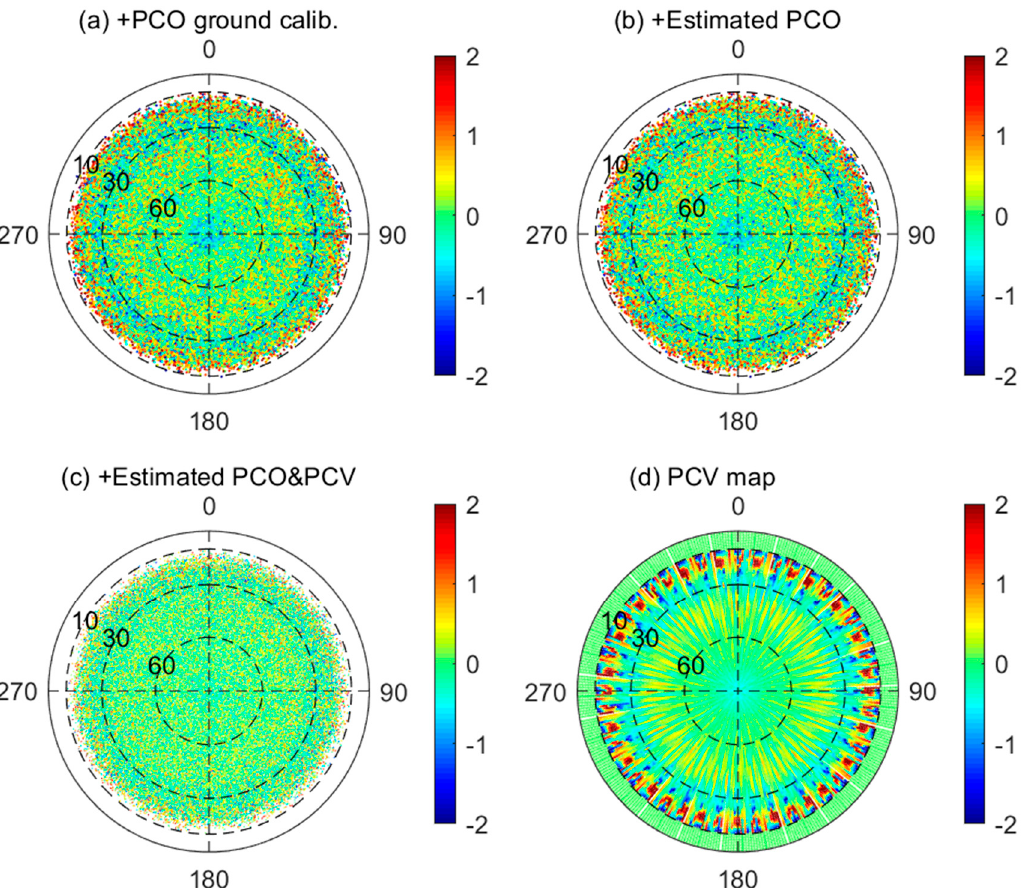
Figure 8. Ionosphere-free carrier phase residuals (cm) for DOY 201 to 231, 2018 and azimuth-elevation diagram of the 5° × 2° phase center variation (PCV) map (cm) for the CSES positioning antenna. Figure ( a ) shows the residuals of the POD solution with PCO ground calibration only; figure ( b ) shows the residuals of the POD solution with estimated PCO; figure ( c ) shows the residuals of the POD solution with estimated PCO and PCV map; figure ( d ) shows the PCV map.